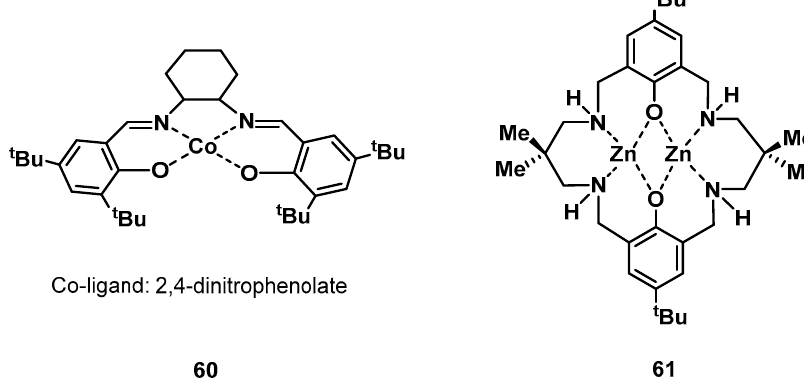
Figure 4. Cobalt and zinc pincer complexes reported to activate carbon dioxide by Müller [582].